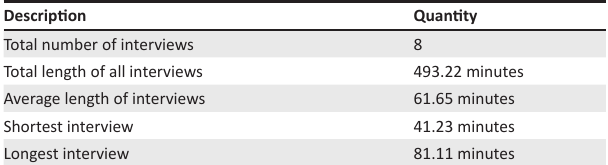
TABLE 3: Interview statistics. TABLE 2: Research design